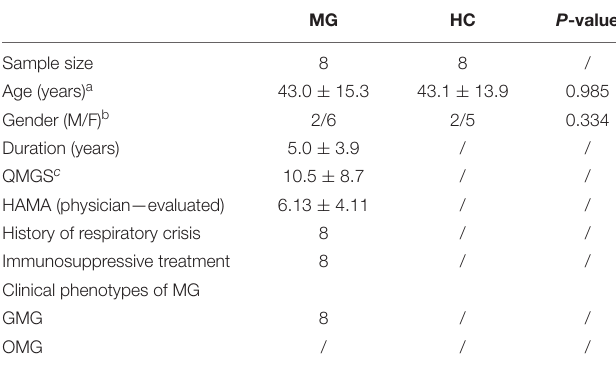
TABLE 1 | Detailed demographic information of the